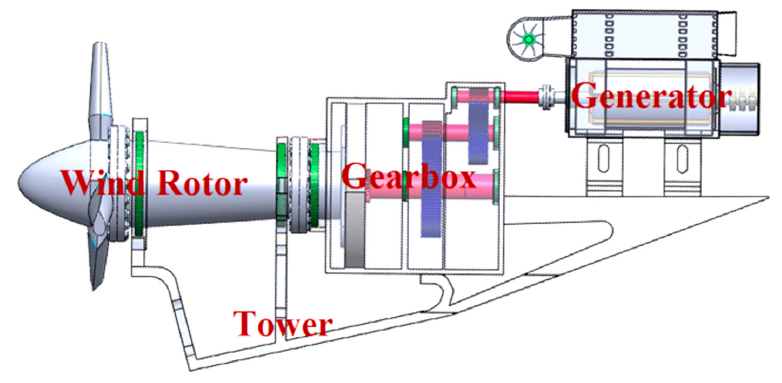
Figure 2. Schematic diagram of WT.